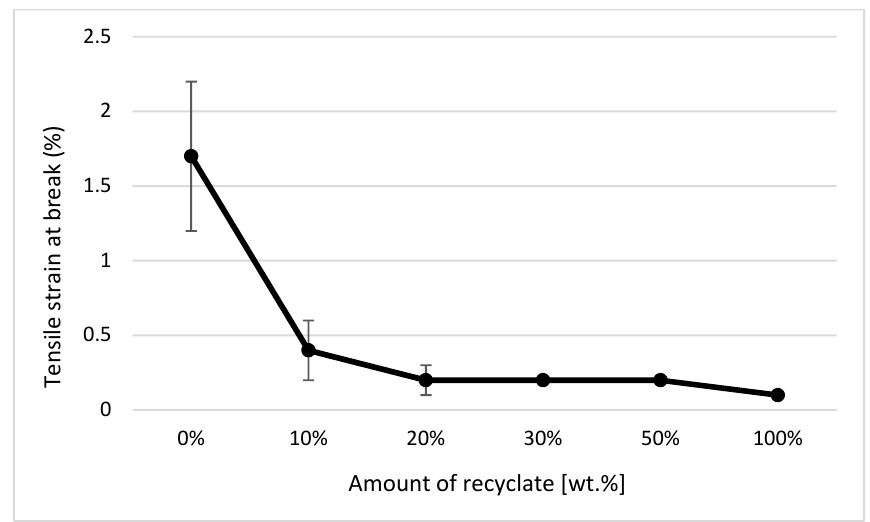
Figure 16. Dependence of stress at the break point on the proportion of weight of the recycled material after exposure of samples to elevated temperature.